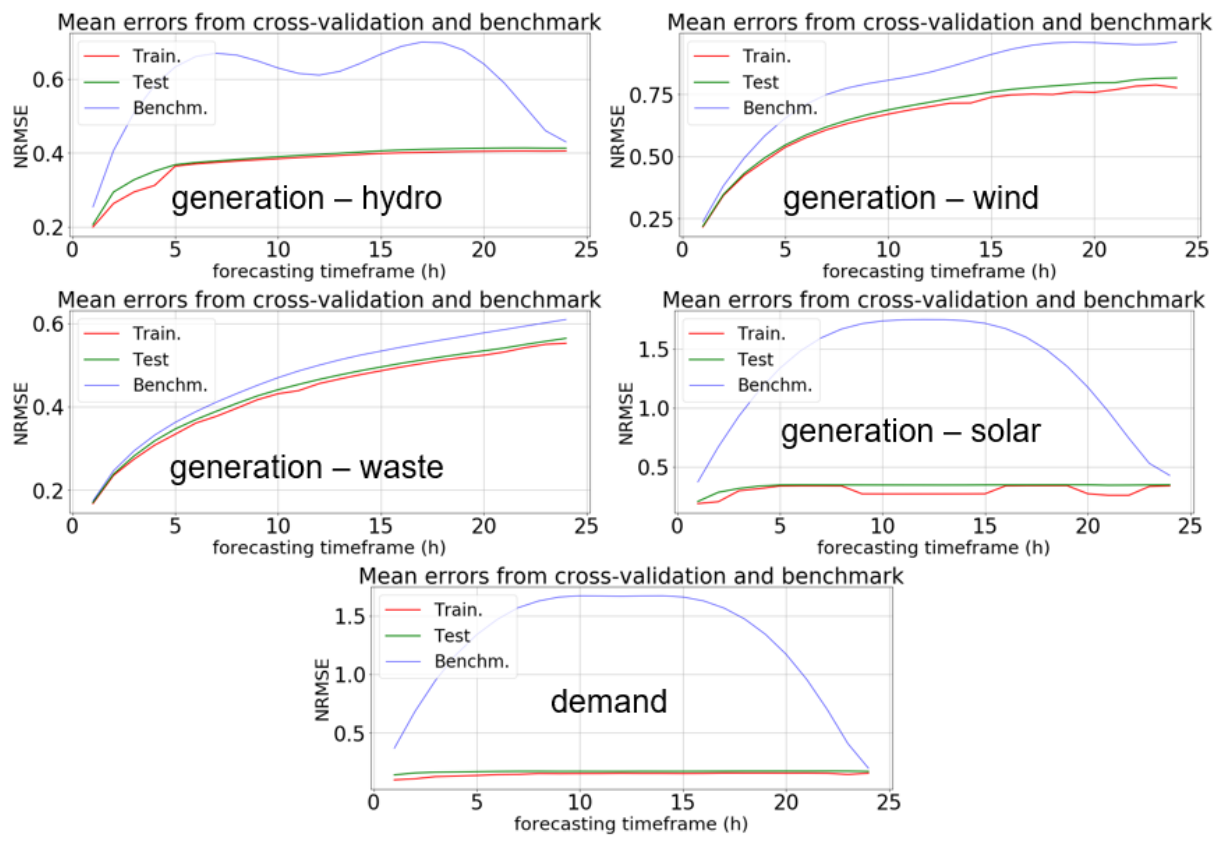
Figure 5. NRMSE per forecasting horizon corresponding to the selected models for Madeira. Table 3. Results (test NRMSE) from training the regression forecasting